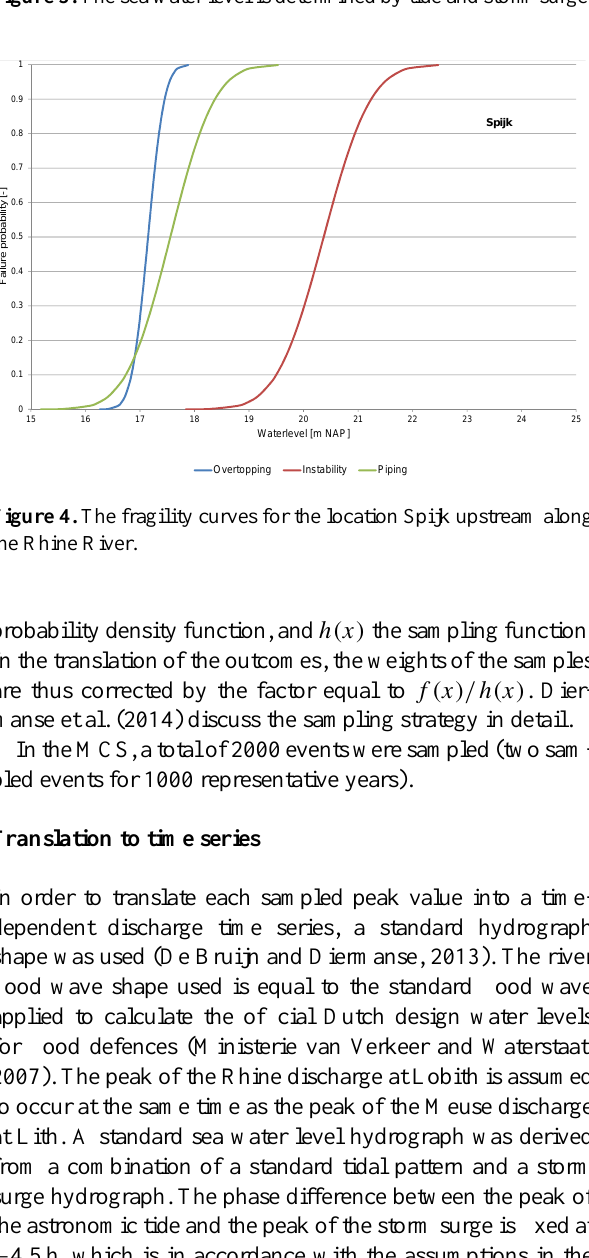
Figure 3. The sea water level is determined by tide and storm surge.